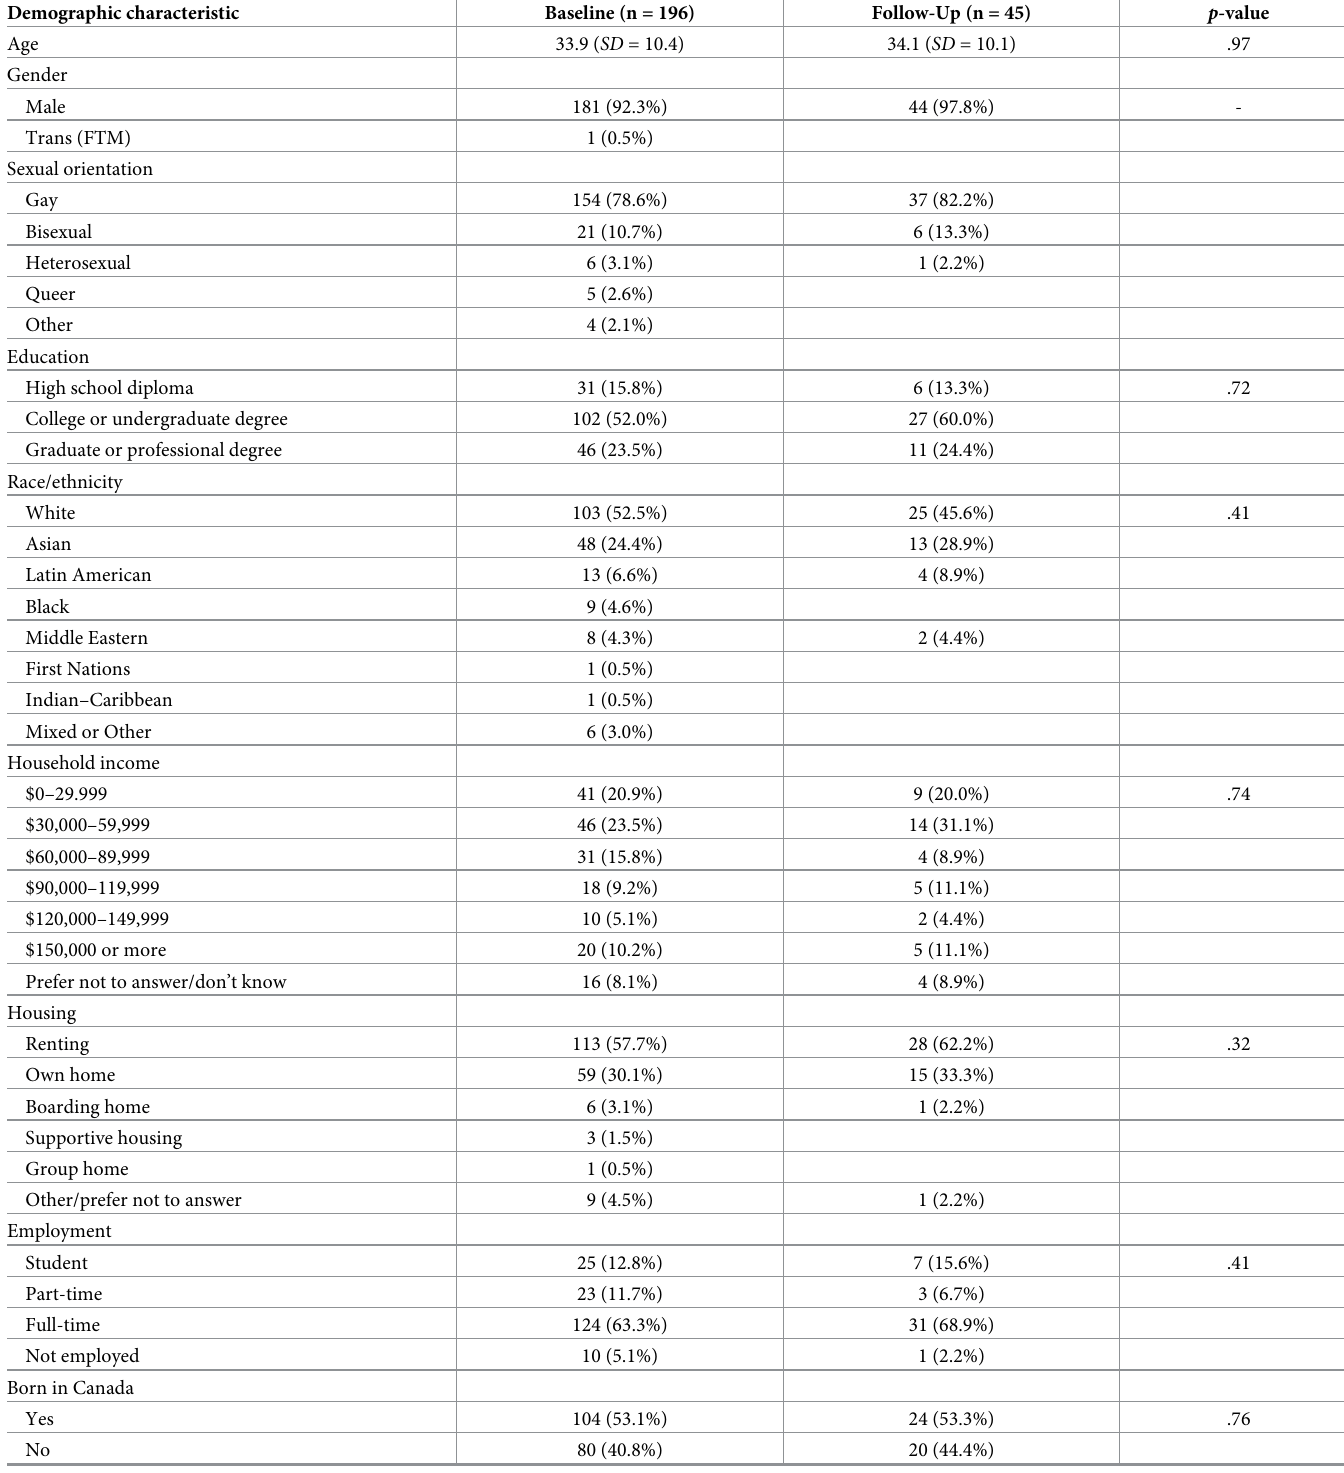
Table 1. Demographic